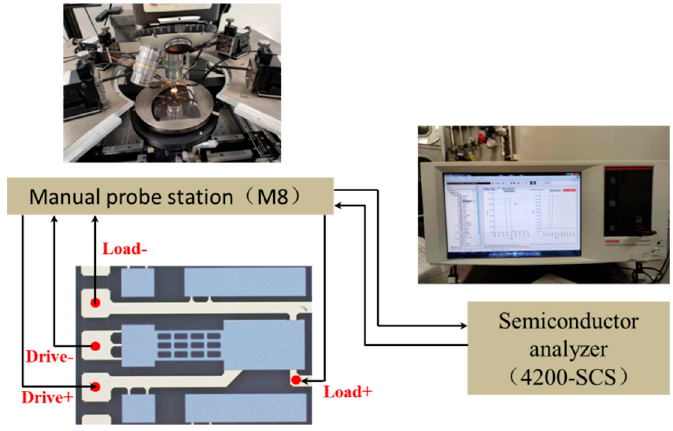
Figure 8. The setup schematic for measuring the actuation voltage.